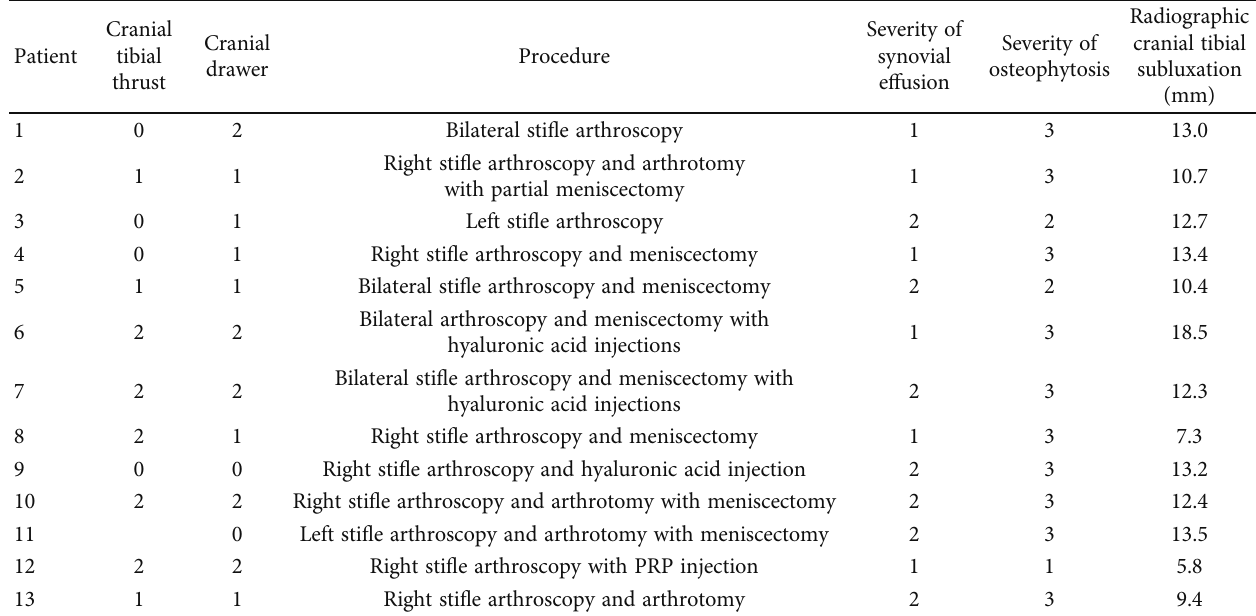
Table 2: Severity of palpable sti fl e passive laxity, radiographic cranial tibial subluxation, and radiographic osteoarthritis in 13 dogs with chronic cruciate ligament rupture.